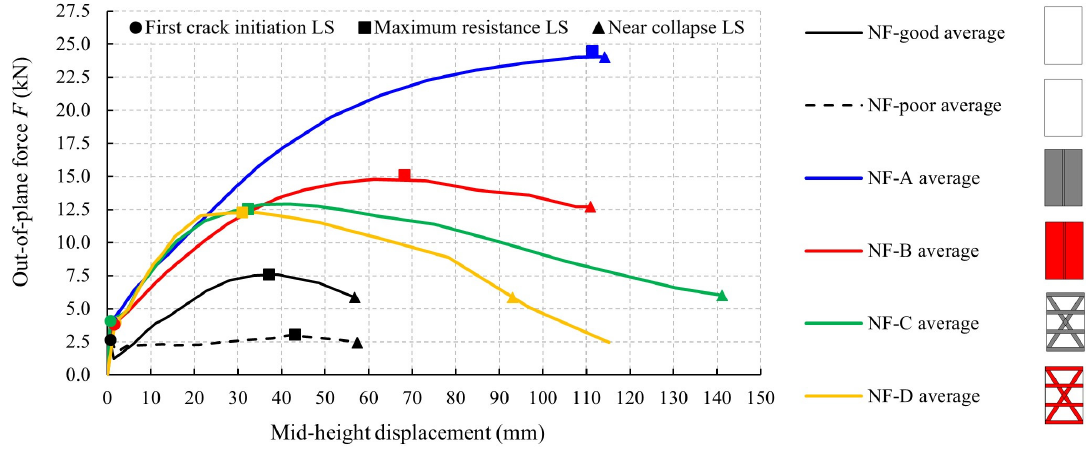
Figure 9. Average hysteresis envelopes of 2nd cycles. Table 2. Average values of out-of-plane force resistance F and corresponding mid-height displacements for each LS. Specimens’